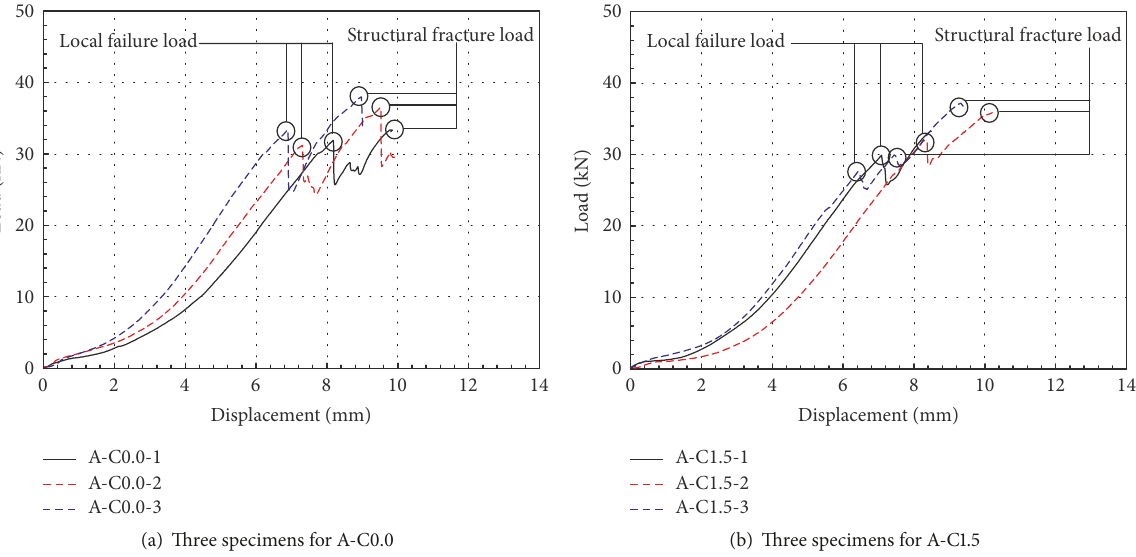
Figure 9: Relationship between load and displacement.